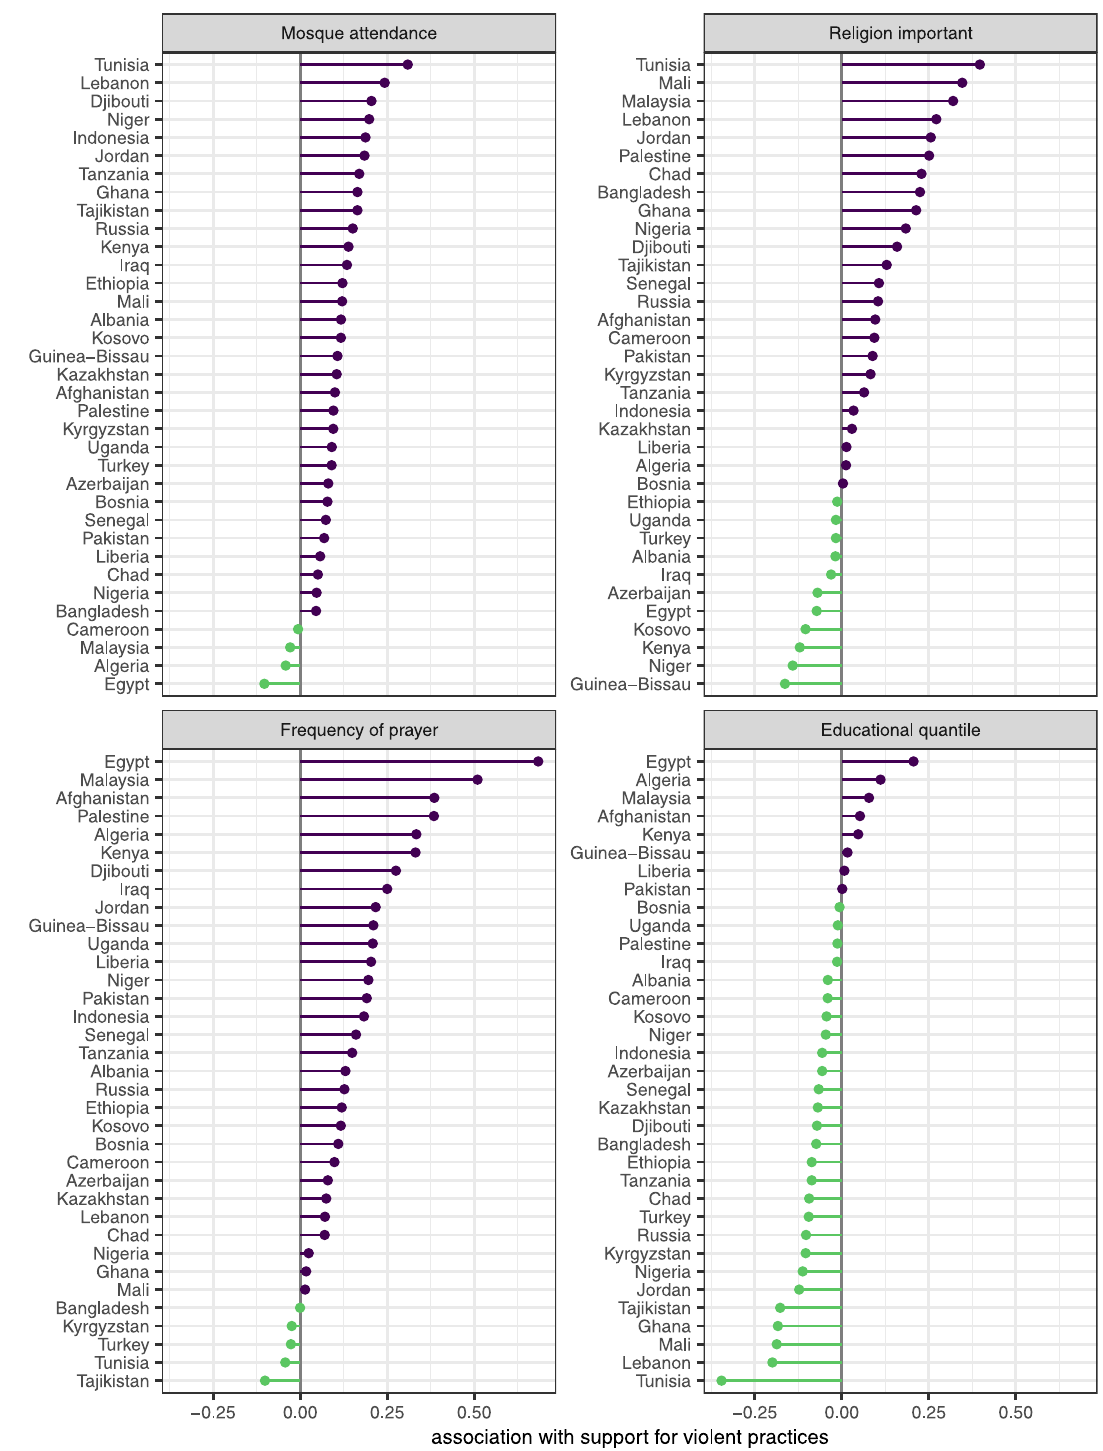
Fig 3. Lollipop plots of the association between religiosity/education and support for violent practices in each country. Values are based on random slopes from Model 3 of Table 1. Each panel is ordered from largest to smallest association. Values are color-coded by